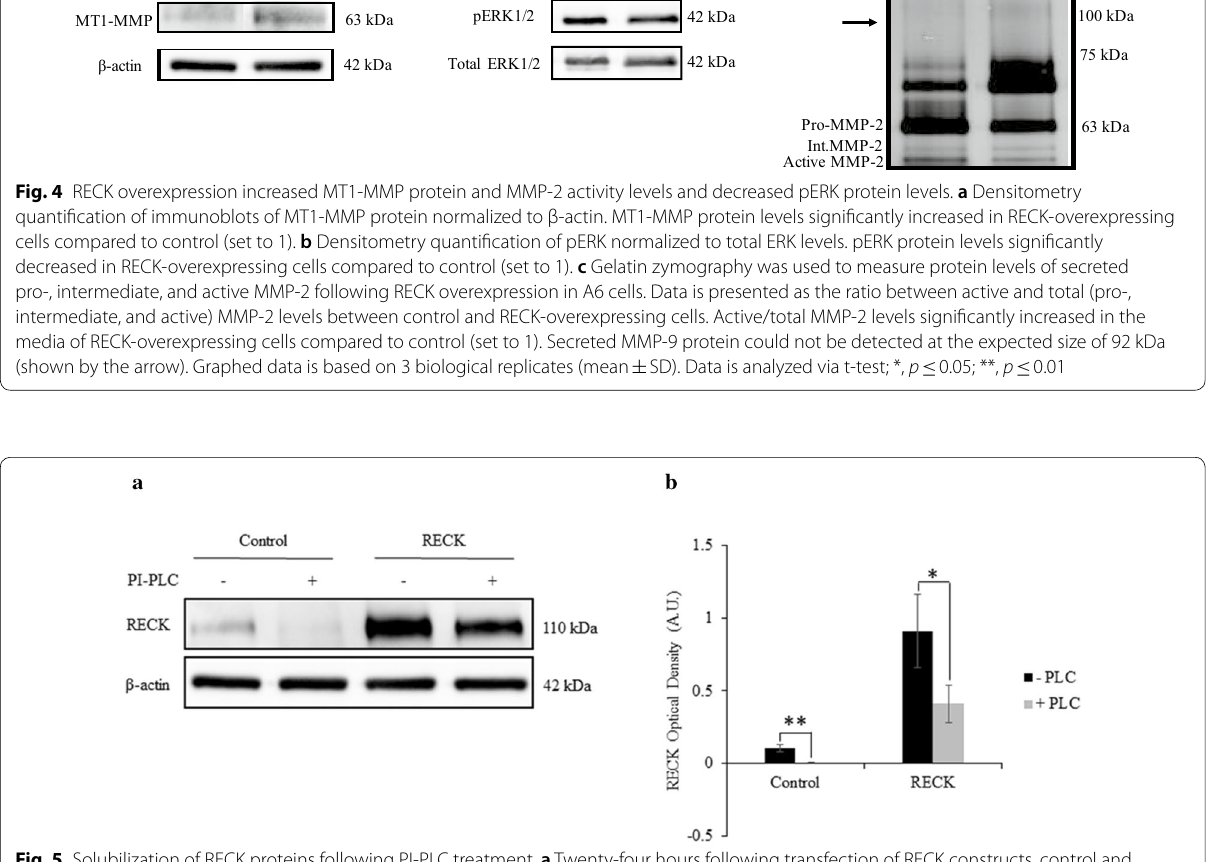
SD). Data is analyzed via t-test; ±